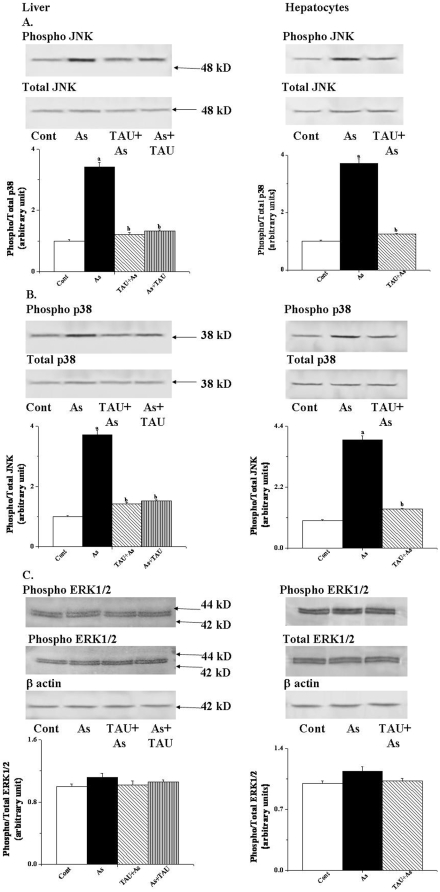
Immunoblot analysis on MAPKinase family proteins in response to As and taurine (TAU+As and As+TAU).Panel A: Phospho and total JNK, Panel B: Phospho and total p38, Panel C: Phospho and total ERK1/2. β actin was used as an internal control. Data represent the average ± SD of 6 separate experiments in each group. “a” indicates the significant difference between the normal control and As treated groups, “b” indicates the significant difference between the As treated and taurine treated groups. (Pa<0.05, Pb<0.05).